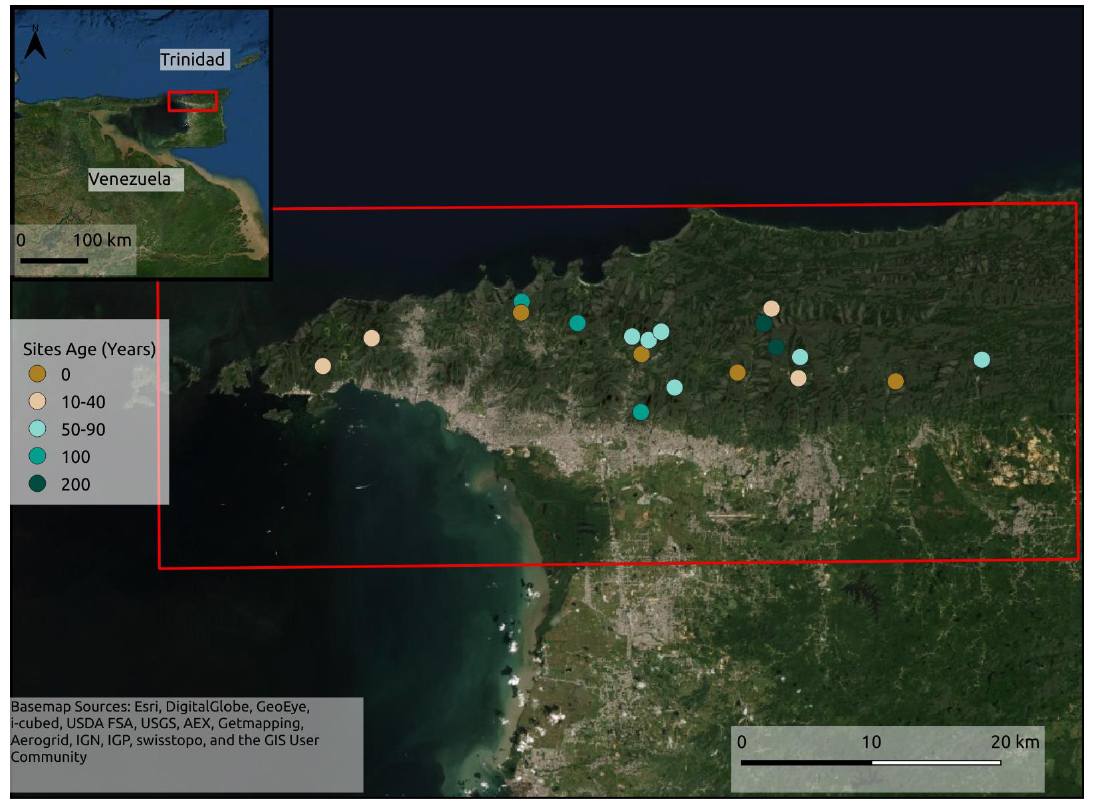
Figure 1. Site locations in the Northern Range of Trinidad (n = 19 total). There were four active sites (0 years of regeneration), four 10–40 yo, six 50–80 yo, two 100 yo secondary forests, and two primary forest sites.